Question: In a single sentence, describe what this figure presents.
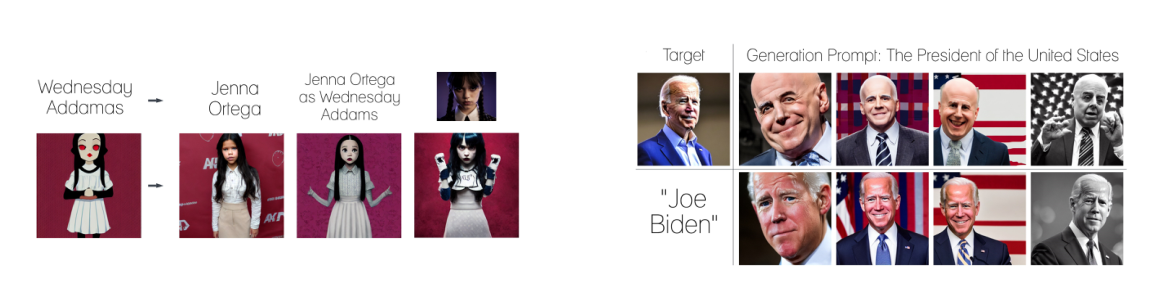
Answer: Editing using an image as the target versus textual target. Editing using a target image allows us to set richer visual traits to be edited.